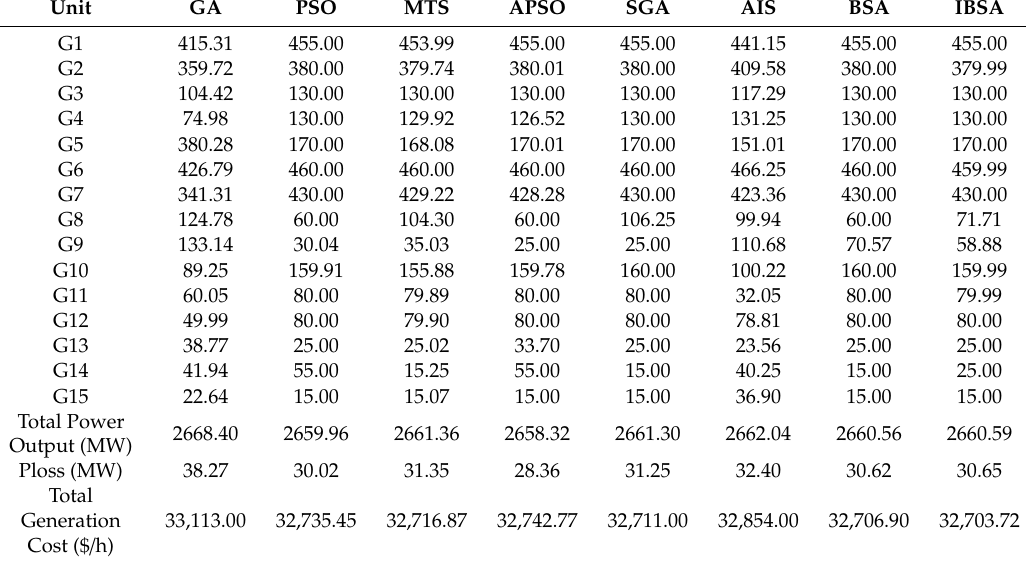
Table 8. Dispatch results of System 2.